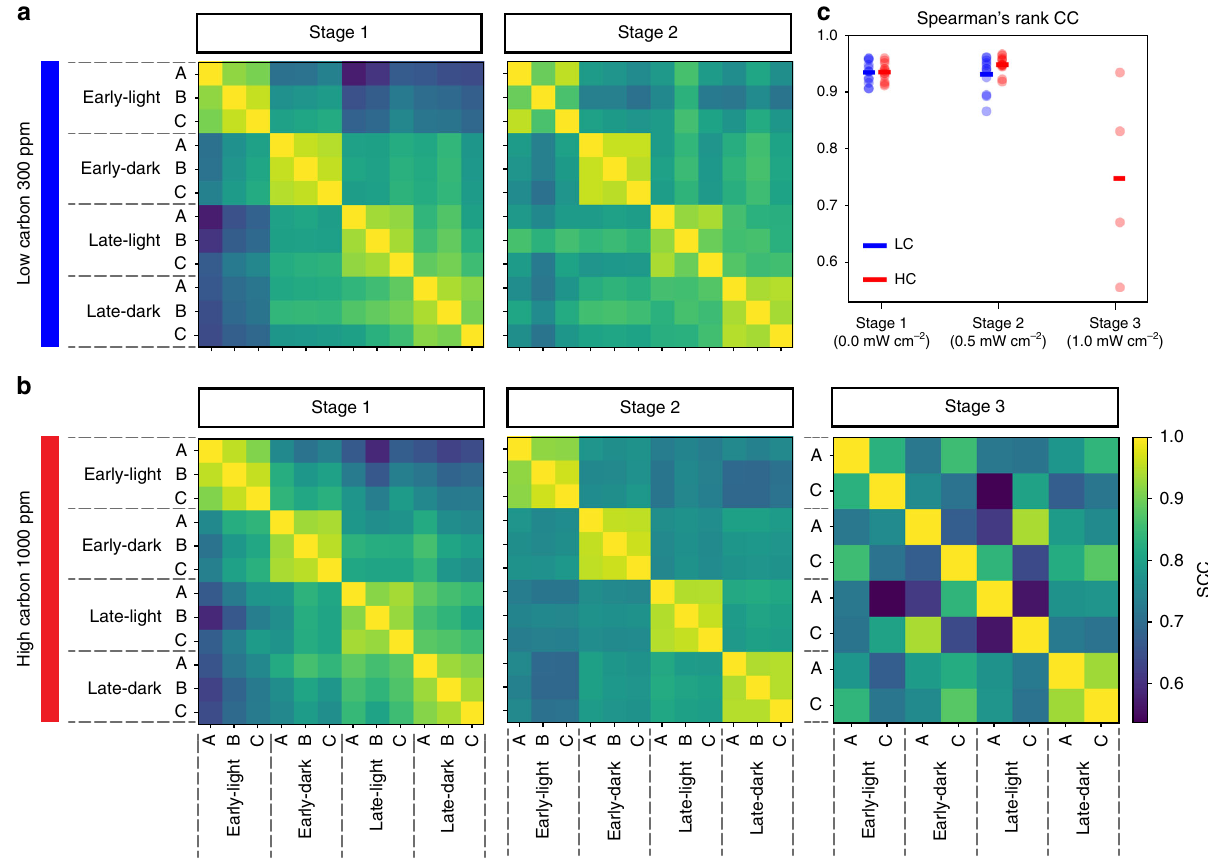
Fig. 3 Replicate variability in diurnal cycle and growth phase transcriptome states prior to collapse. Spearman ’ s rank correlation coef fi cients (SCCs) between transcriptomes across different L:D cycles, phases of growth, and stage of experiment in LC ( a ) and HC ( b ) conditions exposed to incrementally higher UVR doses during the different stages. SCC heatmap shows high similarity of transcriptomes from similar environmental conditions across stage 1, while similarity decreases in stages 2 and 3 of LC and HC conditions, respectively (see color bar for scale). c Dotplot of SCCs shows that transcriptomes became less correlated to each other in the stage prior to collapse (i.e., stage 2 for LC conditions and stage 3 for HC